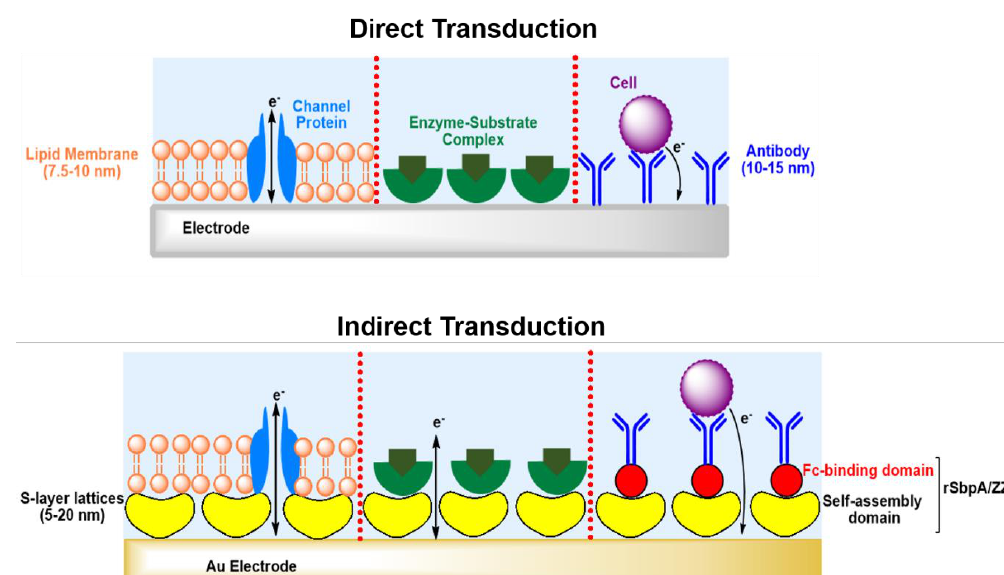
Figure 6. Direct and indirect transduction (not drawn to scale). In direct approach, the electron transfers are close to the surface, whereas in the indirect one, electron shuttles between the reaction site and the sensor surface. In the proposed model, the S-layer protein lattice constitutes an intermediate matrix. In the lipid-based biosensor (left), electrons transfer from the outer membrane to the inner membrane and vice versa via a channel protein. In the detection biosensor (middle and right), electrons transfer between the enzyme–substrate complex and cell / antibody and electrode surface, respectively. The S-layer lattice provides an immobilization matrix and ion reservoir. The pores of the S-layer lattice ensure no impact on the electron transfer. Fc: fragment crystallizable; rSbpA / ZZ: recombinant S-layer protein from Lysinibacillus sphaericus CCM 2177 with fused Fc-binding Z-domain (synthetic analog of immunoglobulin G (IgG-binding B—domain) of protein A of Staphylococcus aureus ).